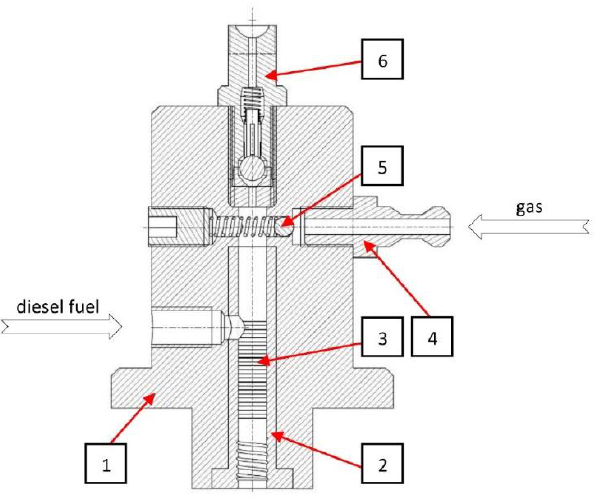
Fig. 5. Delivery section of hypocycloid pump: 1 – body of delivery sec- tion, 2 – cylinder, 3 – section labyrinth seal, 4 – gas stub pipe, 5 – one- way gas valve, 6 – one-way outlet